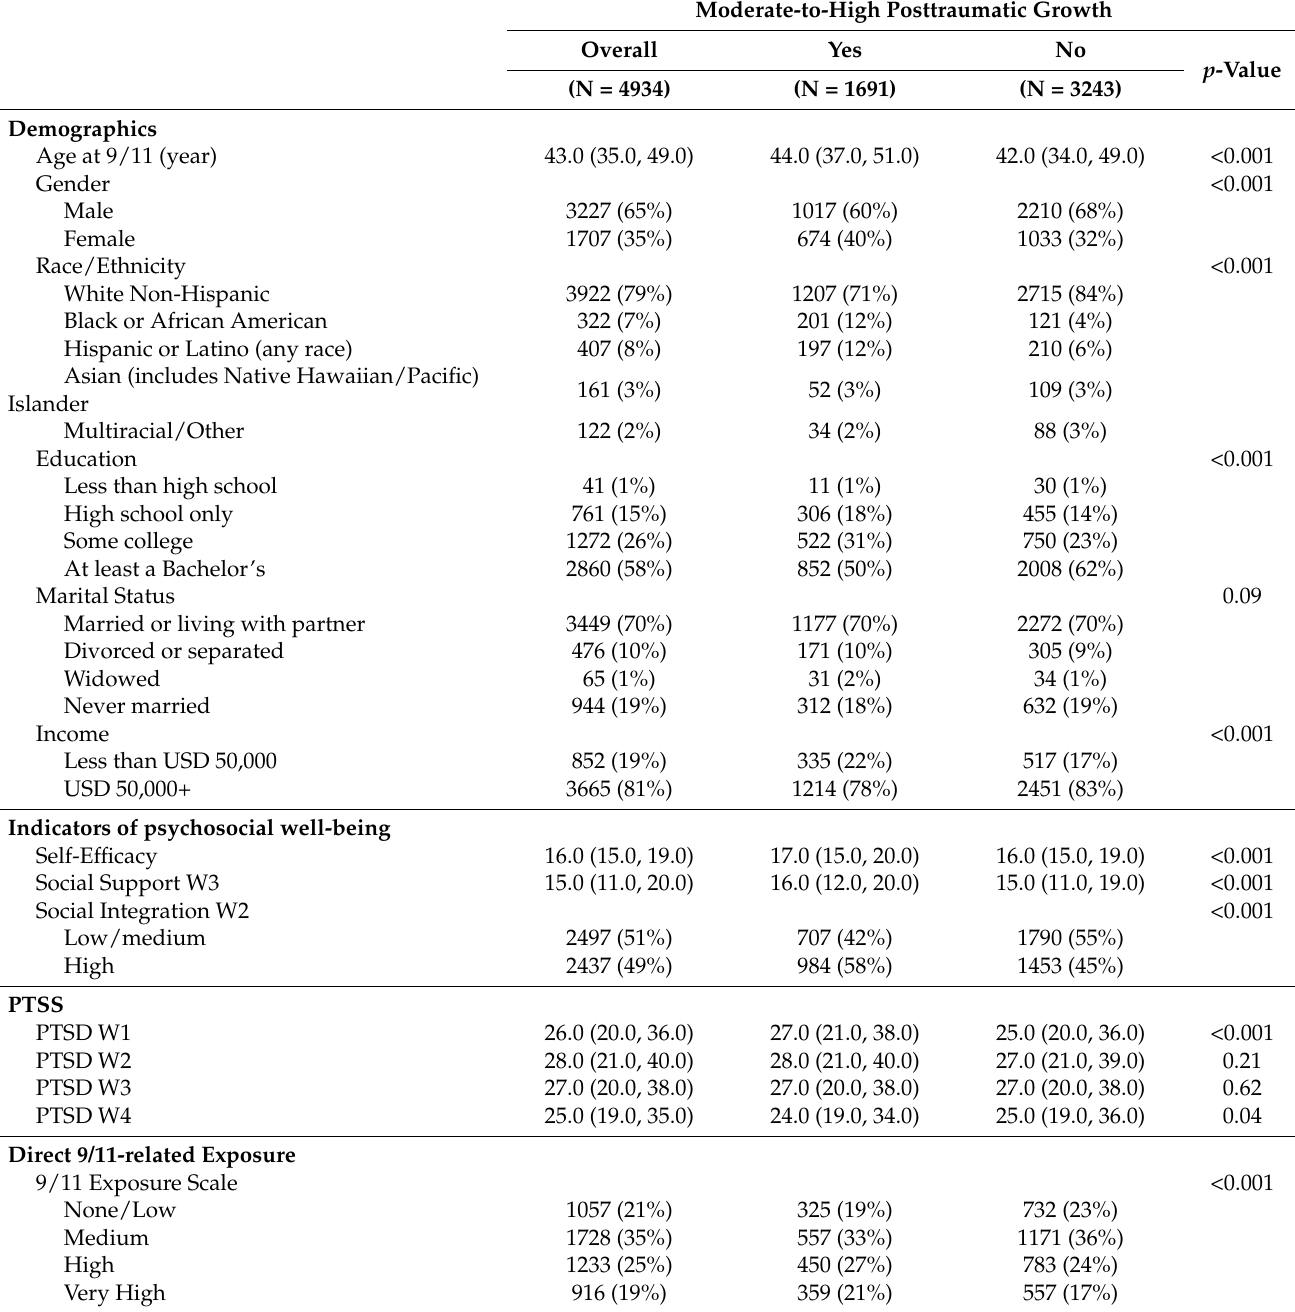
Table 2. Characteristics of Study Sample by Moderate-to-high Posttraumatic